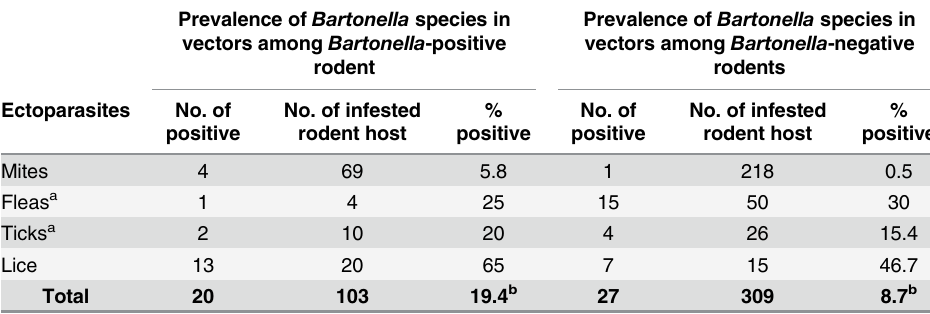
The difference of Bartonella DNA prevalence in ectoparasites collected from Bartonella -posi- tive and Bartonella -negative rats was investigated and presented in Table 7. Among Bartonella - positive rats, 20/103 (19.4%) ectoparasite pools were positive for Bartonella species. In contrast, only 27/309 (8.7%) ectoparasite pools were positive from Bartonella -negative rats. Of these Bartonella -positive ectoparasites, louse pools possessed the highest prevalence of 65% (13/20) and 46.7% (7/15) for positive and negative rats, respectively (Table 7). In general, Bartonella DNA prevalence in ectoparasites collected from positive rats (19.4%) were higher significantly (Chi-Square Tests, P = 0.003) comparing to ectoparasites from negative rats (8.7%).